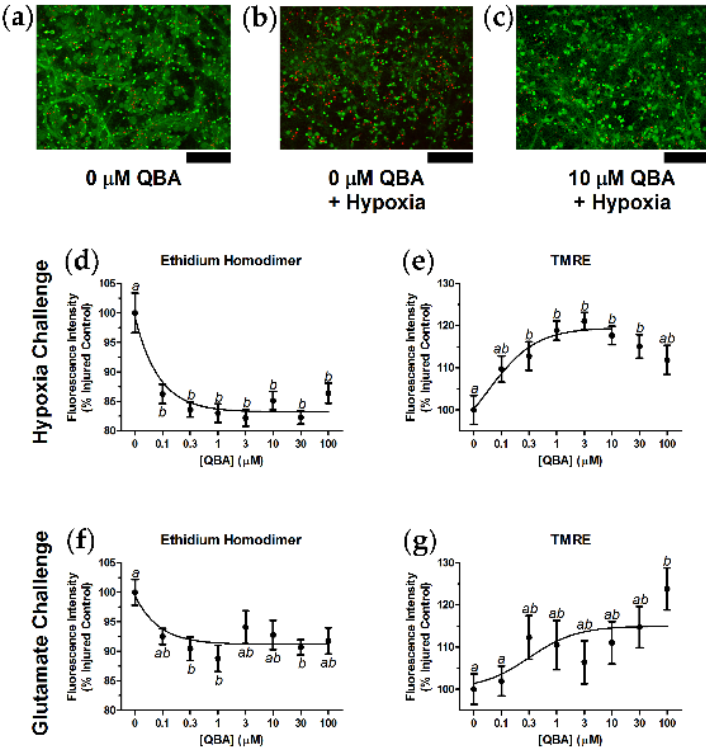
Figure 2. QBA decreased neuron death and increased mitochondrial health after hypoxia challenge and after glutamate challenge. ( a ) Control cells had qualitatively greater calcein AM staining (green), a marker of live cells, and less ethidium homodimer staining (red), a marker for dead cells, than ( b ) neurons challenged with hypoxic conditions (<0.3% O 2 for 48 h). ( c ) The addition of QBA (10 μ M) to hypoxic conditions reduced the number of dead cells. Similar results with QBA addition were observed in the presence of glutamate (25 μ M) challenge (not shown). ( d ) Quantitation of ethidium homodimer fluorescence indicated that QBA decreased hypoxia-induced cell death by approximately 15%. ( e ) Conversely, separate experiments with TMRE, a marker of healthy, properly polarized mitochondria, demonstrated that QBA increased mitochondrial health in hypoxic neurons by 15–20%. ( f ) Concentration-response curve for QBA effects on glutamate-induced cell death, and ( g ) concentration-response curve for QBA effects on mitochondrial health during glutamate challenge. Lack of shared superscripts indicates data points that differed significantly ( p < 0.05) in Tukey’s post hoc test. N = 13–16 in triplicate over two separate culture runs. Error bars represent the SEM. Scale bars = 100 µ